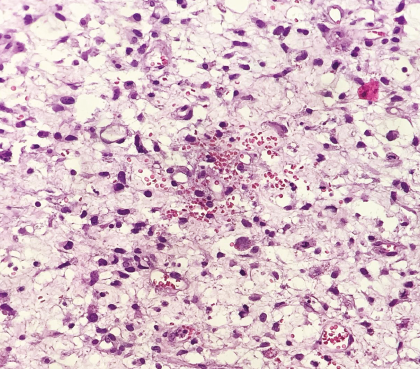
Figure 2: Mixture of highly atypical spindle and giant cells. The larger cells often contain numerous intracytoplasmic hyaline globules (hematoxylin and eosin, 20x magni fi